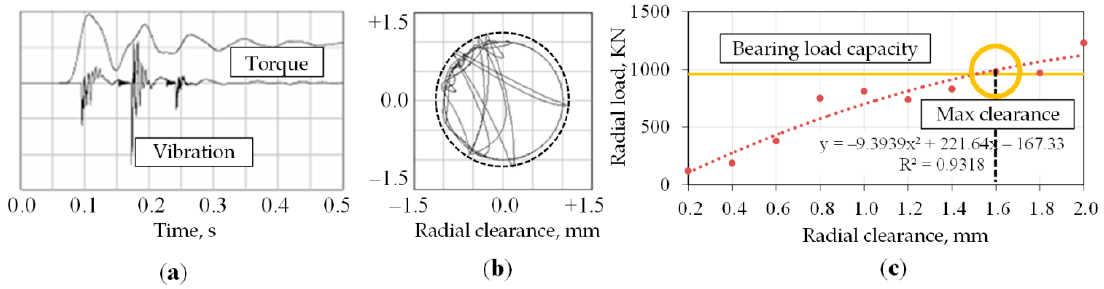
Figure 3. Results of simulations in the time domain: torque and vibration ( a ); trajectory (orbit) of shaft centre of mass motion ( b ); the dependence of maximal radial load in the bearing on radial clearance ( c ).